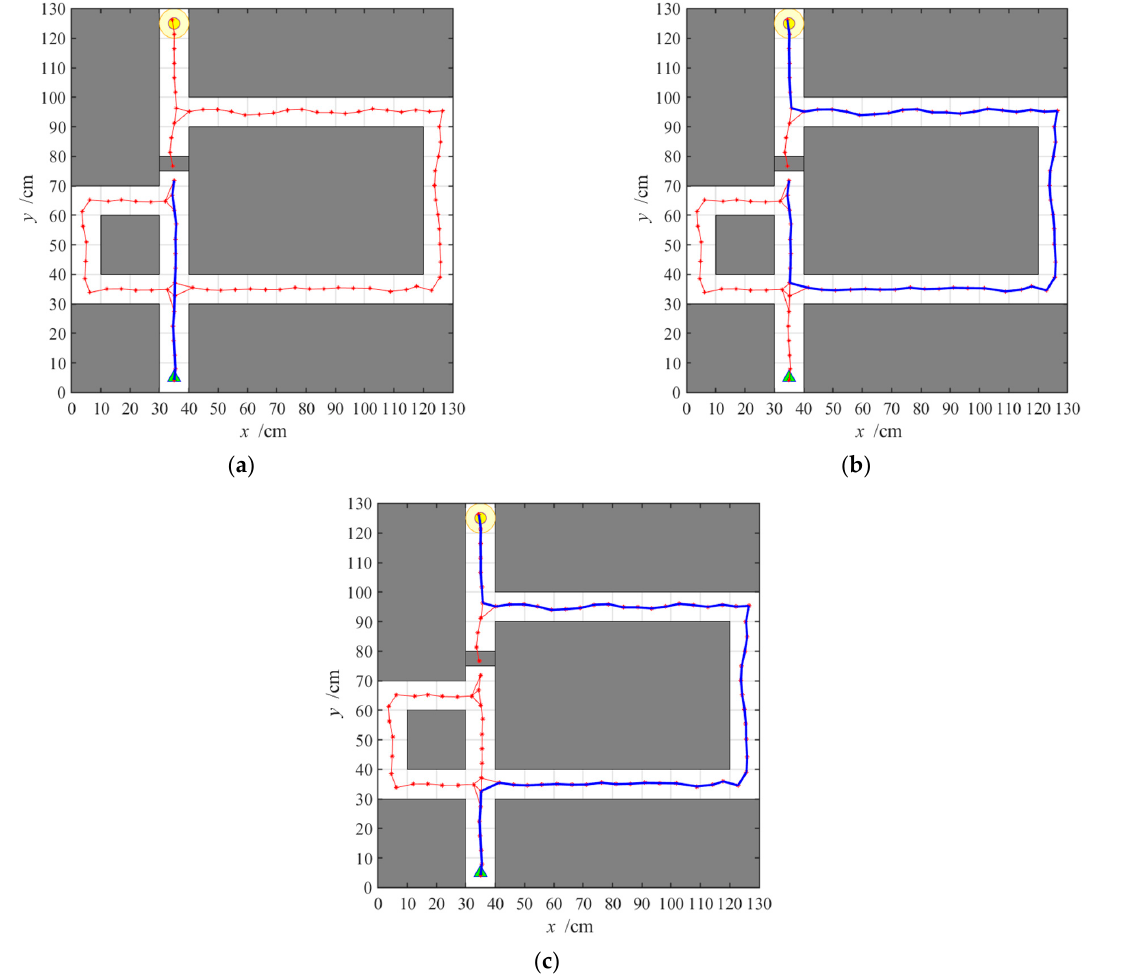
Figure 17. Navigation path with the hippocampal model alone when door B is closed; ( a ) shows the agent’s encounter with the closed door B, and ( b ) shows the newly planned navigation path from current position, both of which constitute the first navigation path. In addition, ( c ) shows navigation path after first navigation.